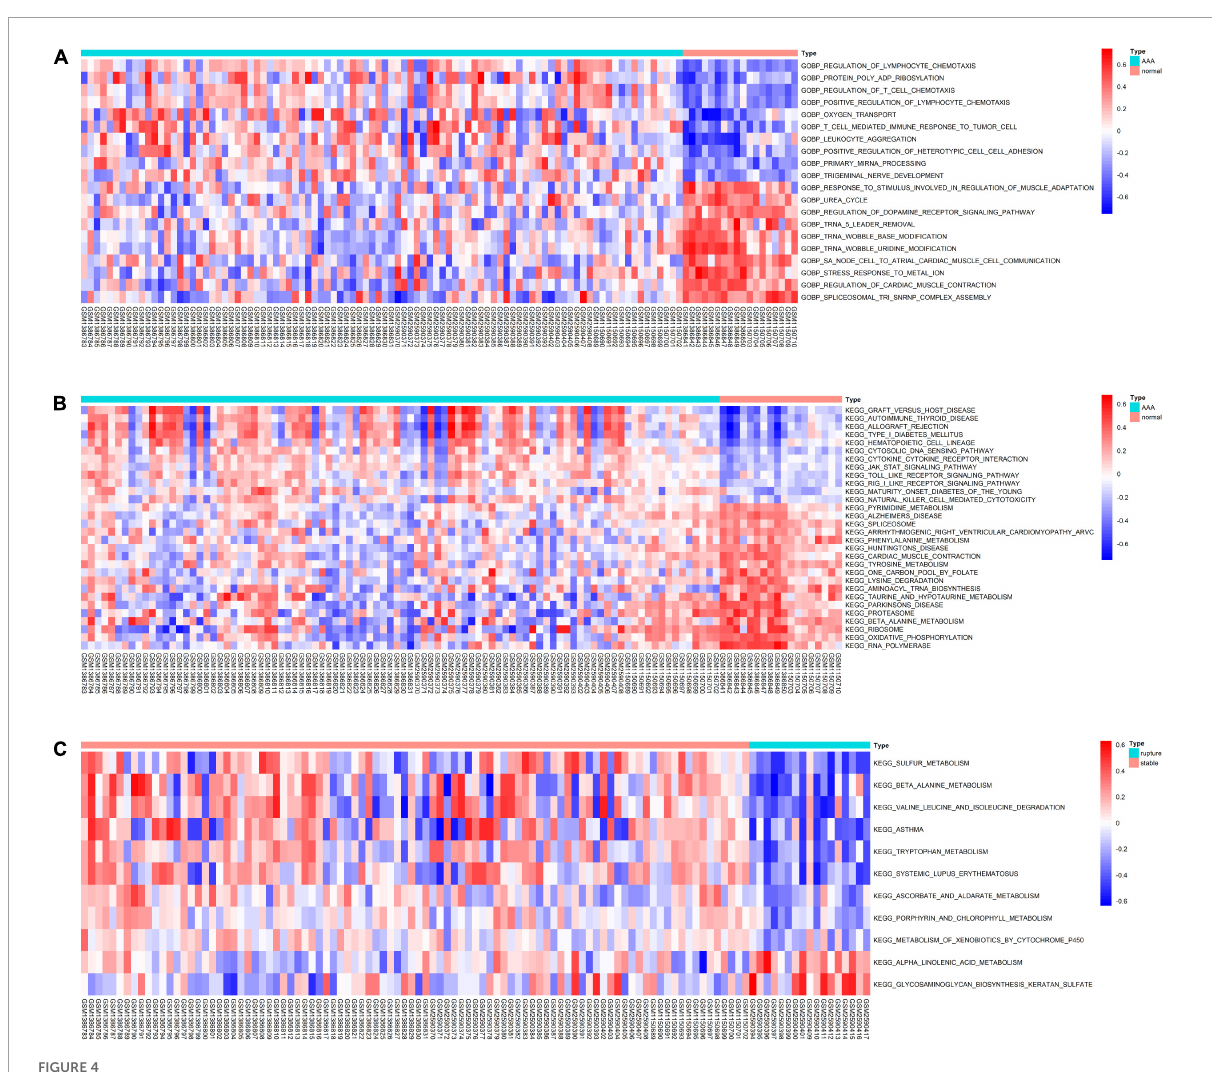
FIGURE4 The results of GSVA. (A) Heatmap of top 20 significantly different GO-BP terms between normal abdominal aorta group and AAA group. (B) Heatmap of top 20 significantly different KEGG pathways between normal abdominal aorta group and AAA group. (C) Heatmap of significantly different KEGG pathways between stable AAA group and aortic rupture group. GSVA, gene set variation analysis; GO-BP, Gene Ontology-biological process; AAA, abdominal aortic aneurysm; KEGG, Kyoto Encyclopedia of Genes and